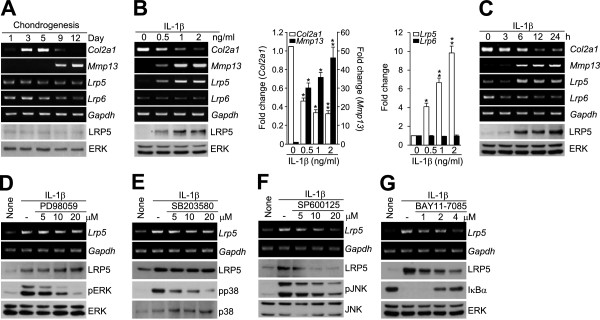
Upregulation of LRP5 in interleukin 1β-treated mouse articular chondrocytes. (A) Mesenchymal cells from mouse embryos were maintained as micromass cultures for 12 days, and the expression levels of Col2a1, Mmp13, Lrp5, Lrp6 and Gapdh were detected by RT-PCR. LRP5 expression was confirmed by Western blot analysis. (B) and (C) Primary cultured mouse articular chondrocytes were treated with the indicated concentrations of interleukin 1β (IL-1β) for 24 hours (B) or with 1 ng/ml IL-1β for the indicated periods (C), and RT-PCR, quantitative RT-PCR and Western blot analysis were carried out. Values are presented as means ± SEM (*P < 0.001, **P < 0.0001; n = 6 independent experiments). (D) through (G) RT-PCR and Western blot analysis were performed on chondrocytes treated with IL-1β (1 ng/ml) for 24 hours in the presence of the indicated inhibitors (micromolar concentrations): PD98059, an extracellular signal-regulated kinase (ERK) inhibitor (D); SB203580, a p38 mitogen-activated protein (MAP) kinase inhibitor (E); SP600125, a c-Jun N-terminal kinase (JNK) inhibitor (F); and (2E)-3-[[4-(1,1-dimethylethyl)phenyl]sulfonyl]-2-propenenitrile (BAY11-7085), an inhibitor of nuclear factor κB α (IκBα) (G).